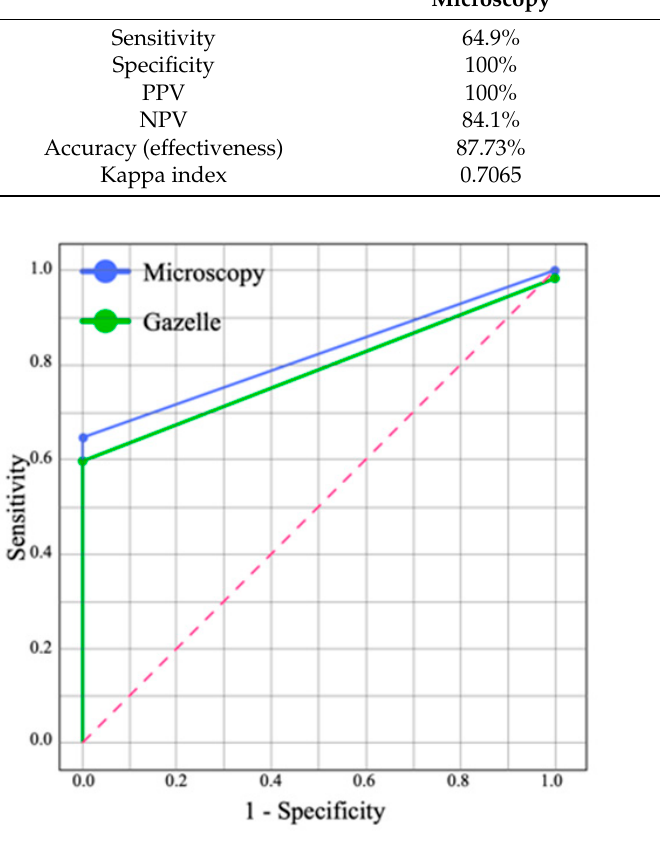
Figure 3. ROC curves for microscopy and Gazelle™ compared with nested PCR as reference test. Gazelle™ presented an AUC of 0.79 (good) and LM an AUC of 0.82 (very good).